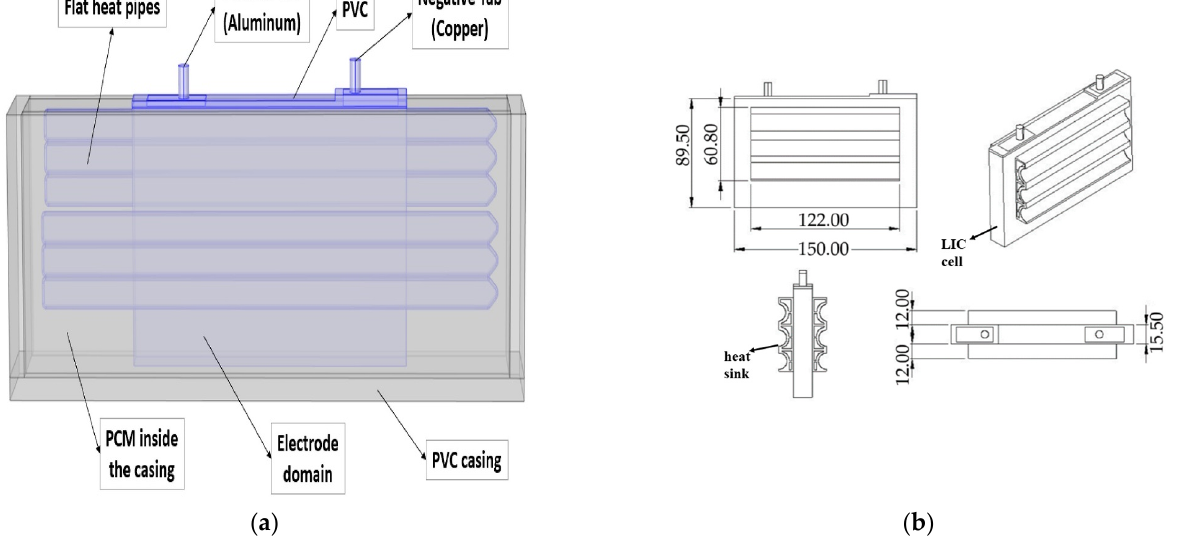
Figure 20. ( a ) Geometry of the hybrid thermal management system incorporating HPs and PCM where blue colors in figure represent flat heat pipes, positive tab and negative tab, reproduced with permission from [174], copyright 2021, Elsevier; ( b ) the heat sink for the LIC cell (unit in mm) [175], open access.